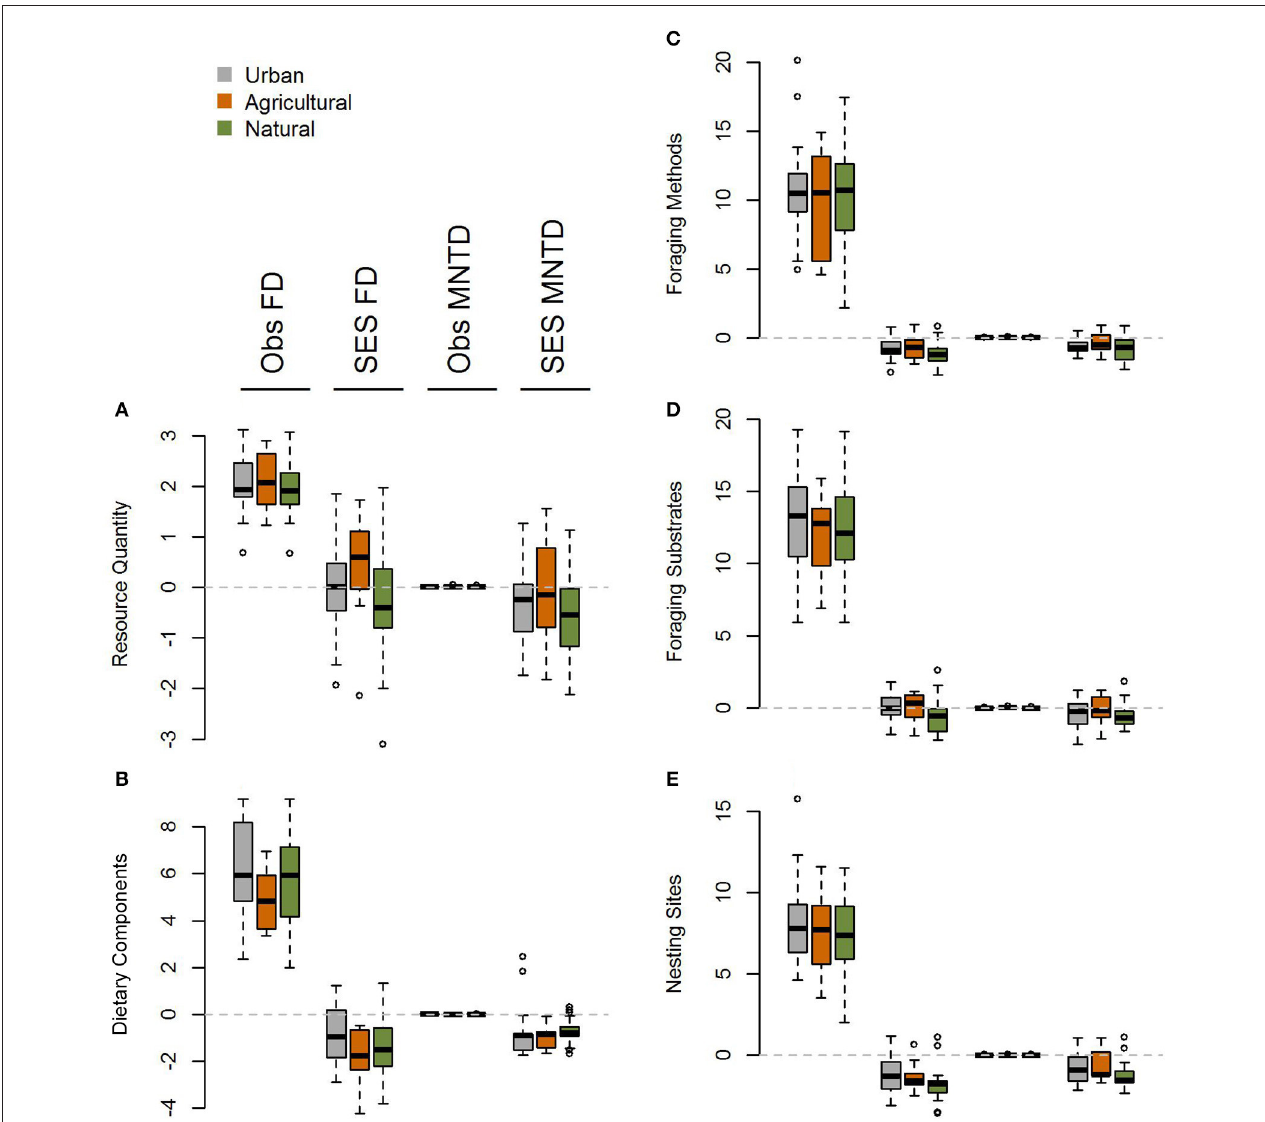
FIGURE 4 | Boxplot comparing single trait axis functional diversity metrics at the global scale for (A) resource quantity, (B) dietary components, (C) foraging methods, (D) foraging substrates, and (E) nesting sites for observed and standardized effect size FD and MNTD metrics in urban assemblages and paired natural and agricultural assemblages. There is no evidence for heterogeneity in the impacts of urbanization across different functional trait